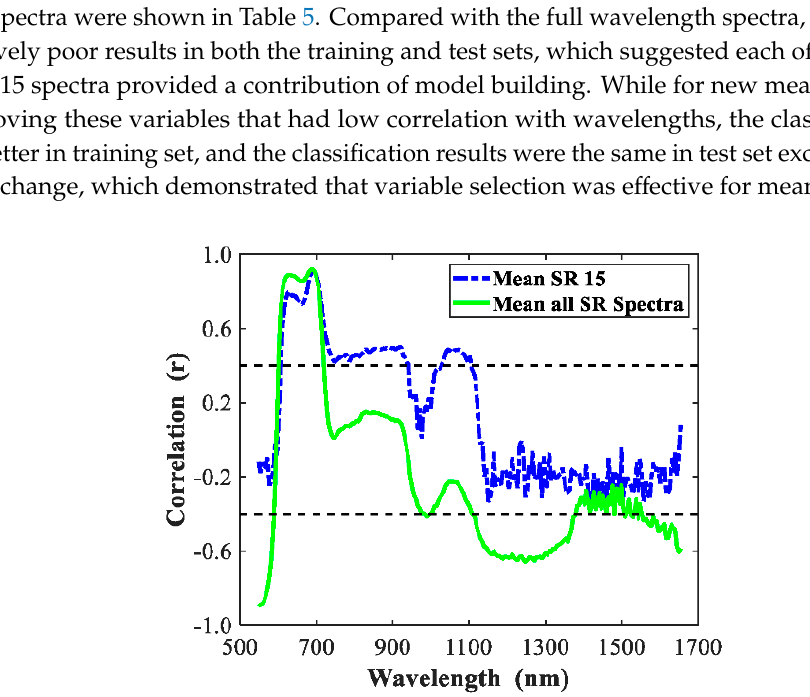
Figure 6. Correlation curves for tomato between six maturity stages and relative reflectance of individual wavelengths for the spectral region of 550–1650 nm.